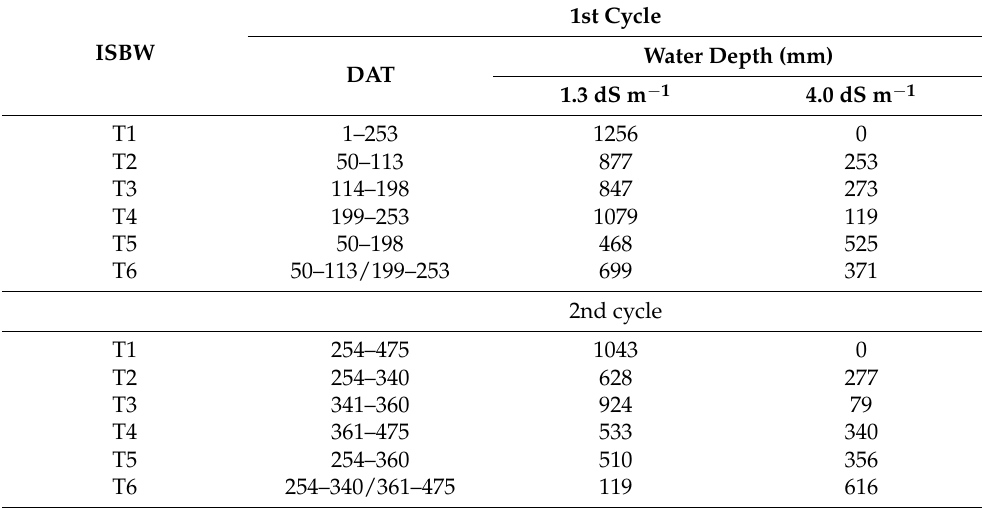
Table 3. Water depth values applied to BRS GA1 yellow passion fruit in different strategies of irrigation with brackish water in the phenological stages.